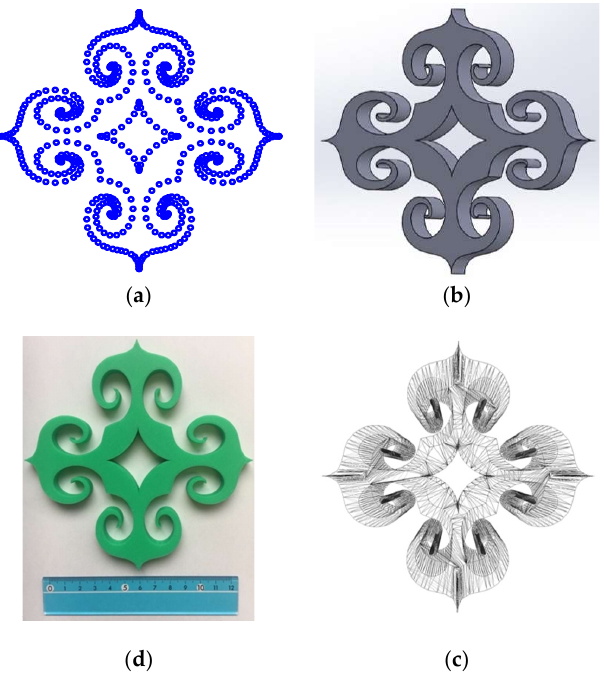
Figure 12. Model-1 based on Ainu motifs. ( a ) Point-cloud; ( b ) Solid CAD model; ( c ) Triangulation